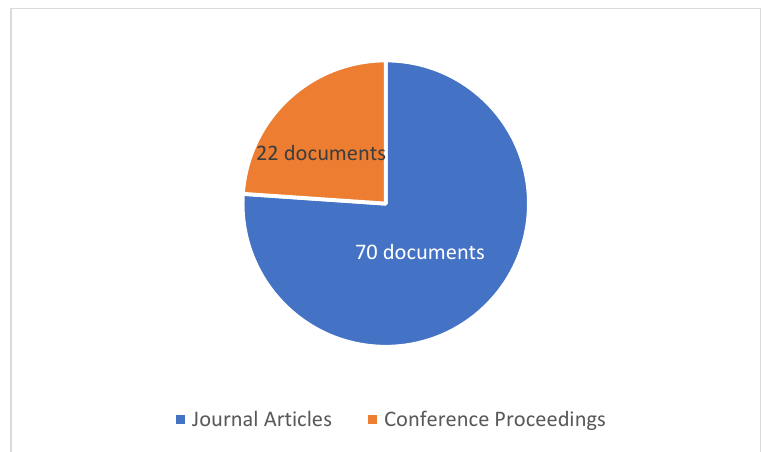
Figure 2 . Type of document collected . Of the 92 documents collected, 70 articles were from peer-reviewed journals and 22 were from conference proceedings. With regard to journal publications, 44 journals had each published one item; the remainder had published 2 or more documents, as shown in Table 3. The journal International Review of Research in Open and Distributed Learning (IRRODL) published 9 articles, the highest number of documents.